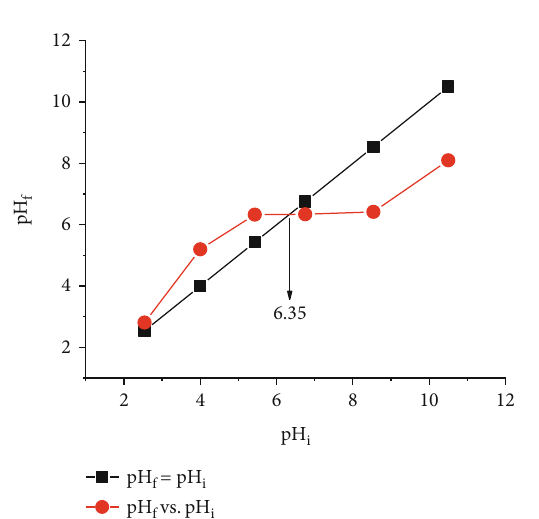
Figure 2: Point of zero charge for PACK adsorbent.